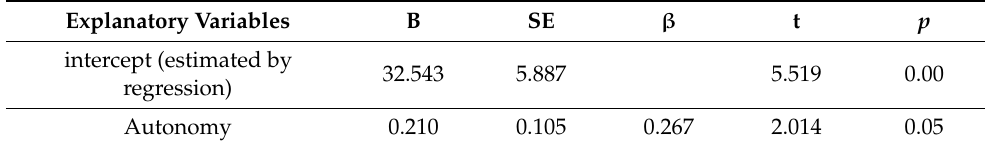
Table 3. Linear-regression summary: dependent variable—high awareness of sustainable energy consumption; explanatory variables—parental attitudes of fathers.